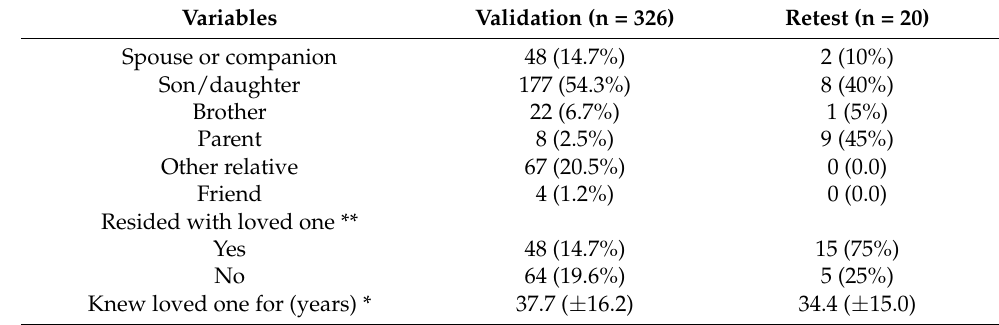
Table 3. Factor loadings, communality, and percentage of variance of items in relation to factors. Item